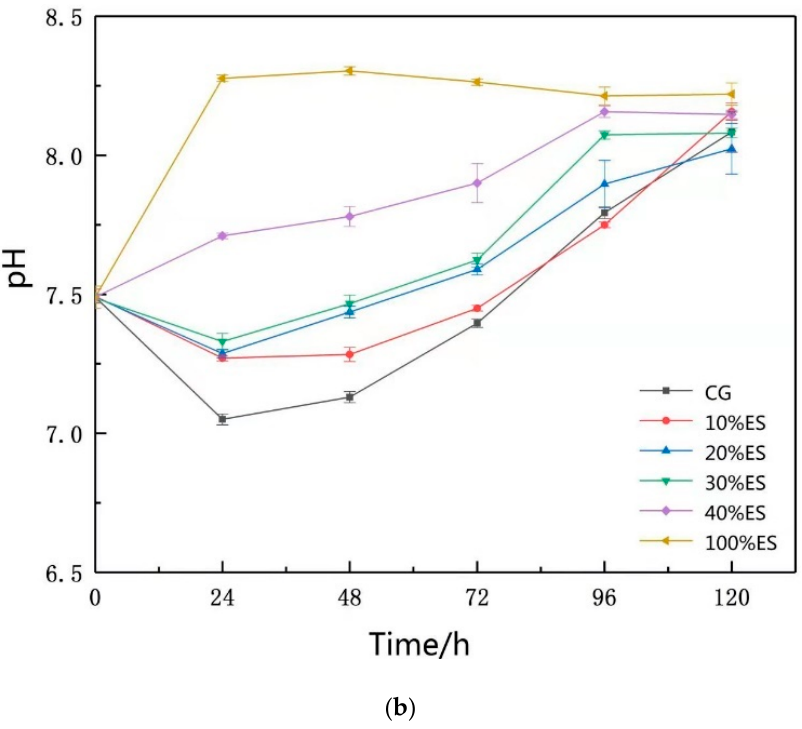
Figure 4. pH values of leaching solutions for CG. ( a ) DS-CG; ( b ) WH-CG.